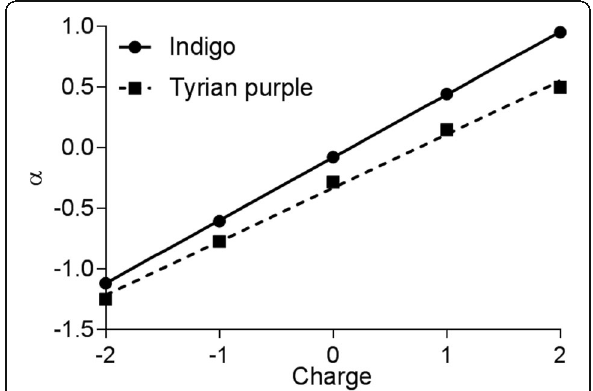
Fig. 6 Linear relationship of the gate coupling ( α ) and the charge values for indigo and Tyrian purple